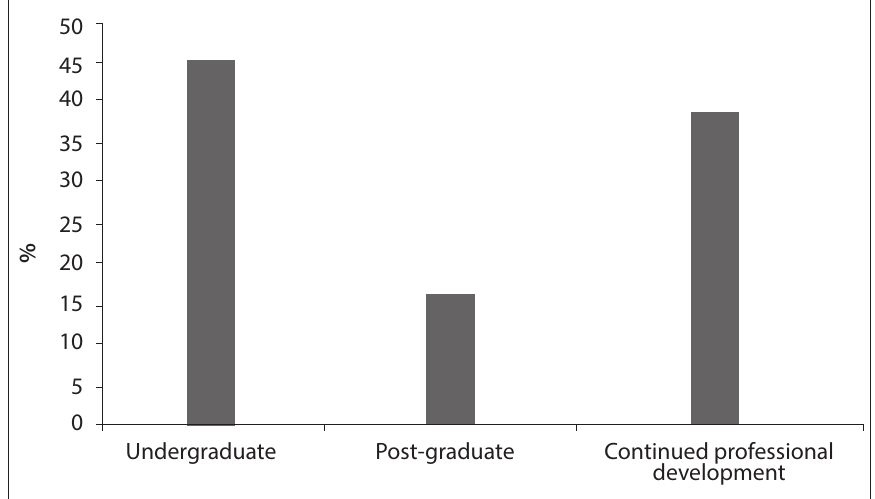
Fig. 2. Respondents’ ( n =22) perceptions regarding necessary level of training